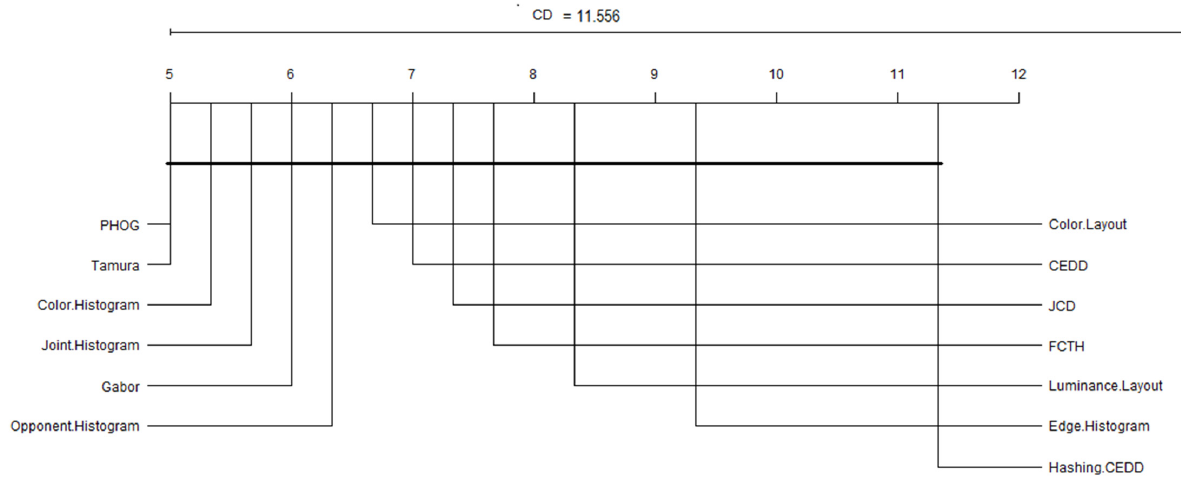
Figure 14. Critical Distance Diagram (CDD) for inverted face images.